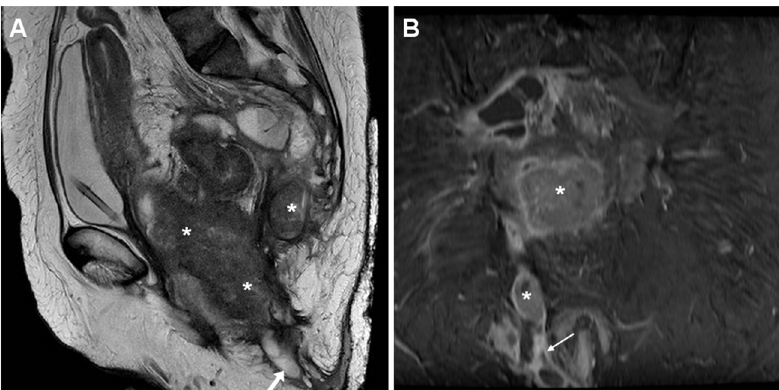
coursed postero-inferiorly towards the perianal skin and showed periph- eral enhancement (thin arrow) on post-gadolinium fat-suppressed T1- weighted acquisition (